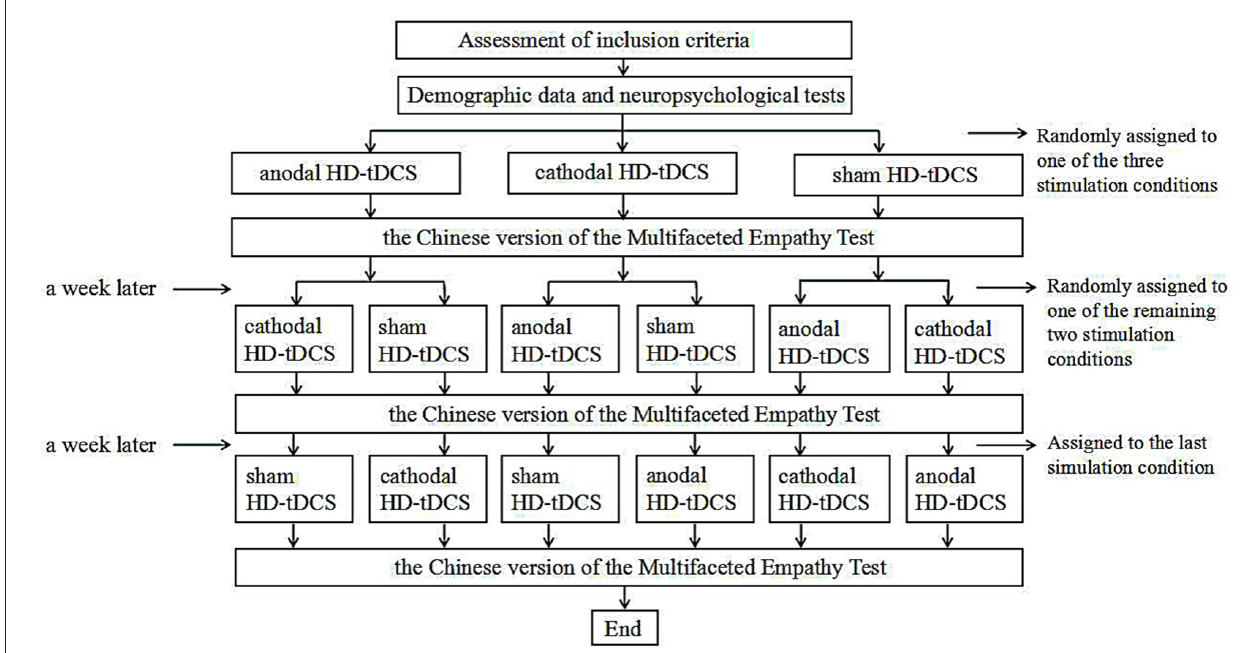
Frontiers in Human Neuroscience |